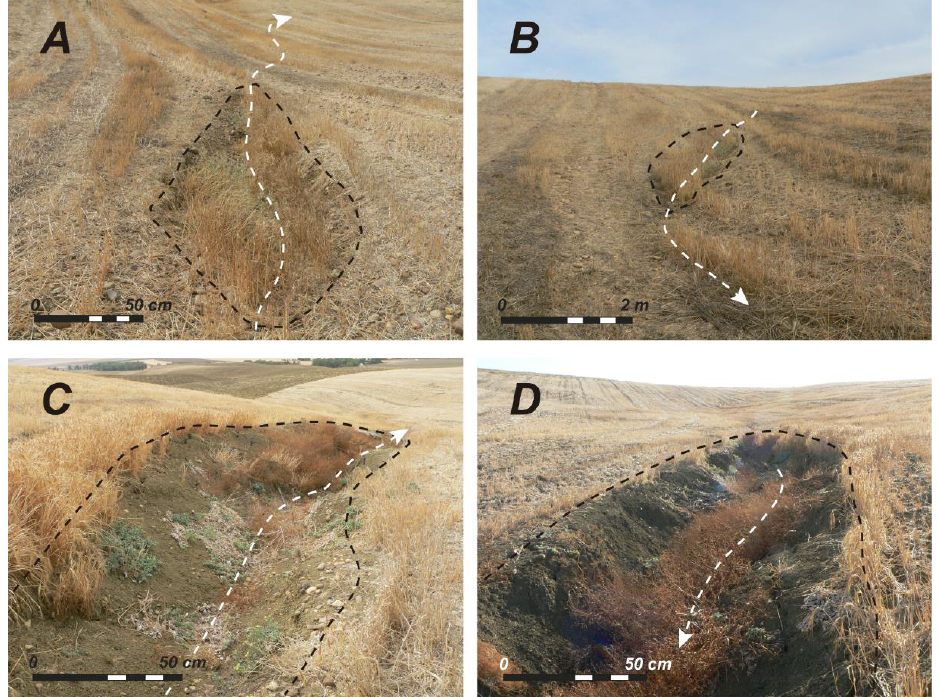
Figure 9. Small channel incisions (inside black dashed polygons) of roughly 1 m width and 0.5 m depth, developed at the headwaters section of some channels. ( A , B ) Downstream and upstream views, respectively, of the channel incision developed in channel 6. ( C , D ) Downstream and upstream views, respectively, of the channel incision developed in channel 13. This incision develops as the channel is trying to re-establish its longitudinal profile that was obliterated by agricultural tillage. The direction of flow in each picture is represented with the white-dashed arrows.